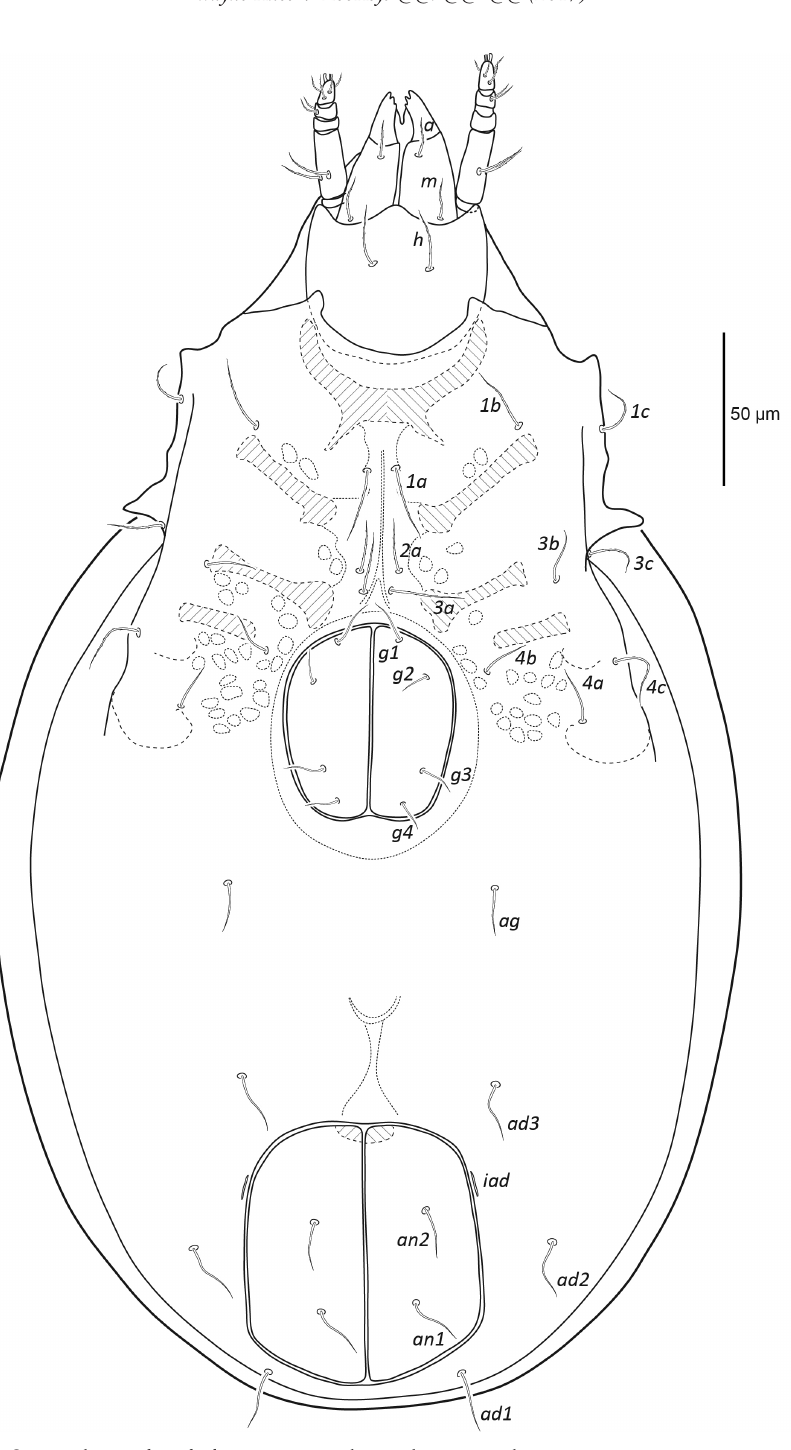
Figure 2. Female Paraleius leahae sp. n. ventral view, legs